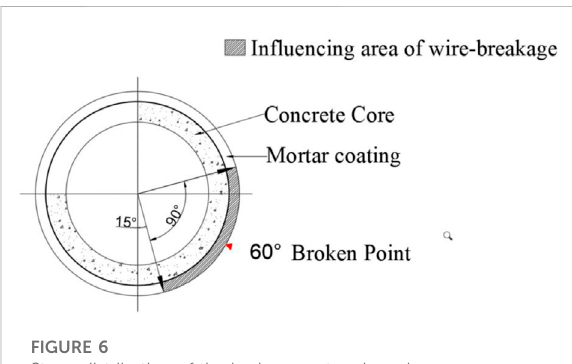
FIGURE 6 Stress distribution of the broken prestressing